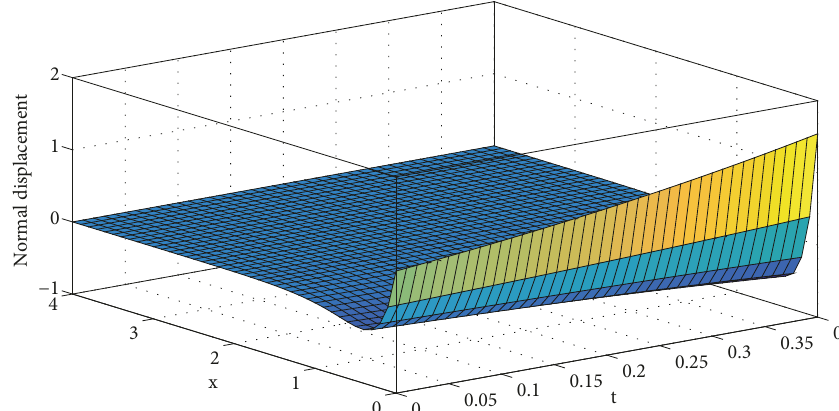
Figure 14: Profile of normal displacement at 𝑛 = 1.0 , 𝐻 0 = 10 5 , and Ω = 0.5 .